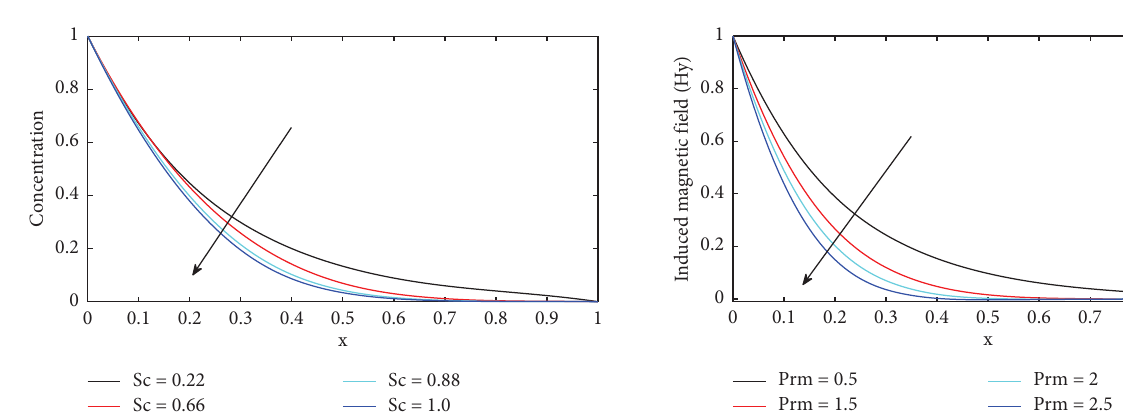
Figure 10: Concentration profles for diferent values of Sc .